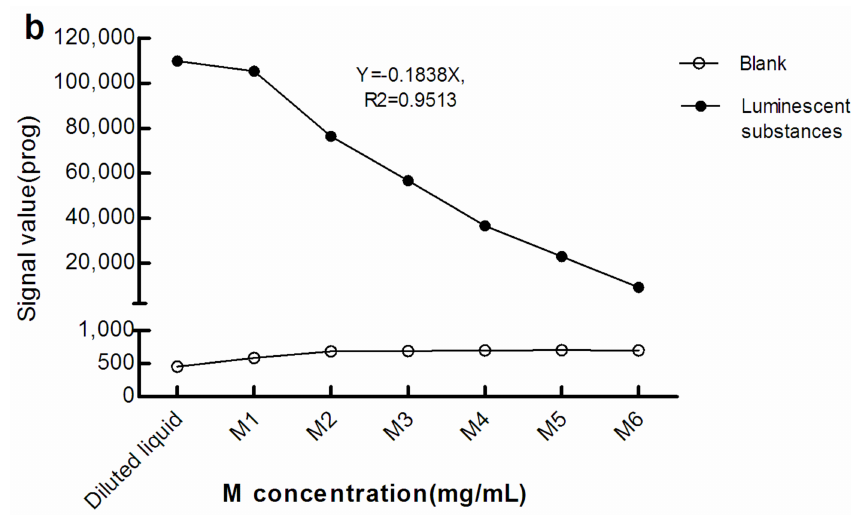
Figure 2. Light signal levels of luminescent materials at different concentrations of M. ( a ) sandwich method; ( b ) competitive method. The reaction system of the blank optical signal used Roche diluent as R1, R2, and the sample, and M1–M6 as M reagent. The reaction system of the light signal level of the luminescent substances was the same as the blank reaction system, except that the sample was replaced with luminescent substances. The concentration of M in the diluted liquid was 0 mg/mL. The concentrations of M1–M6 were 0.72, 1.44, 2.16, 2.88, 3.60, and 7.20 mg/mL, respectively. β -hCG: β -human chorionic gonadotropin; Prog: Progesterone.